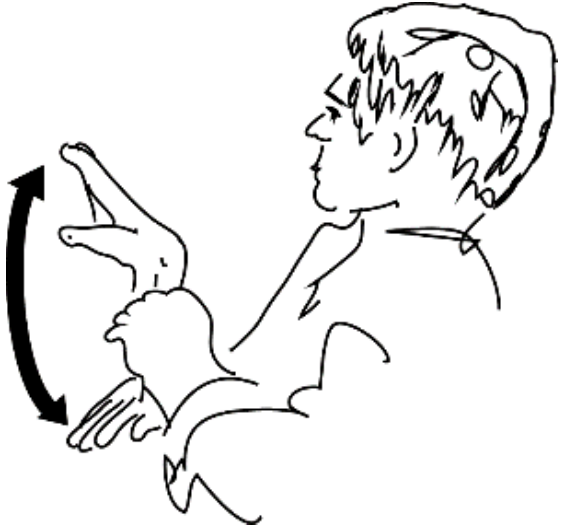
Figure 2. A Tzotzil speaking man issues a COME gesture.